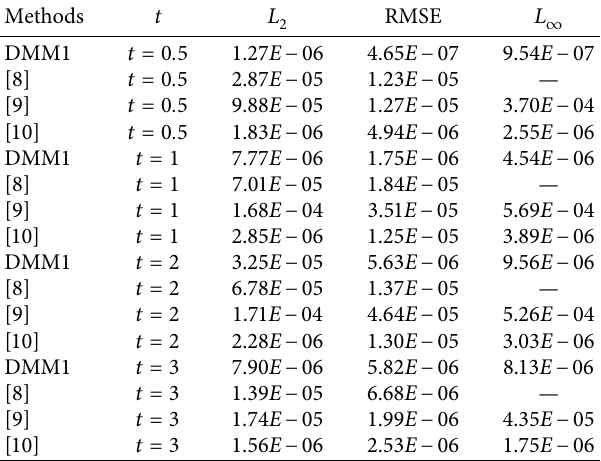
Table 6: Numerical results with α � 50and β � 5 for Example 5.